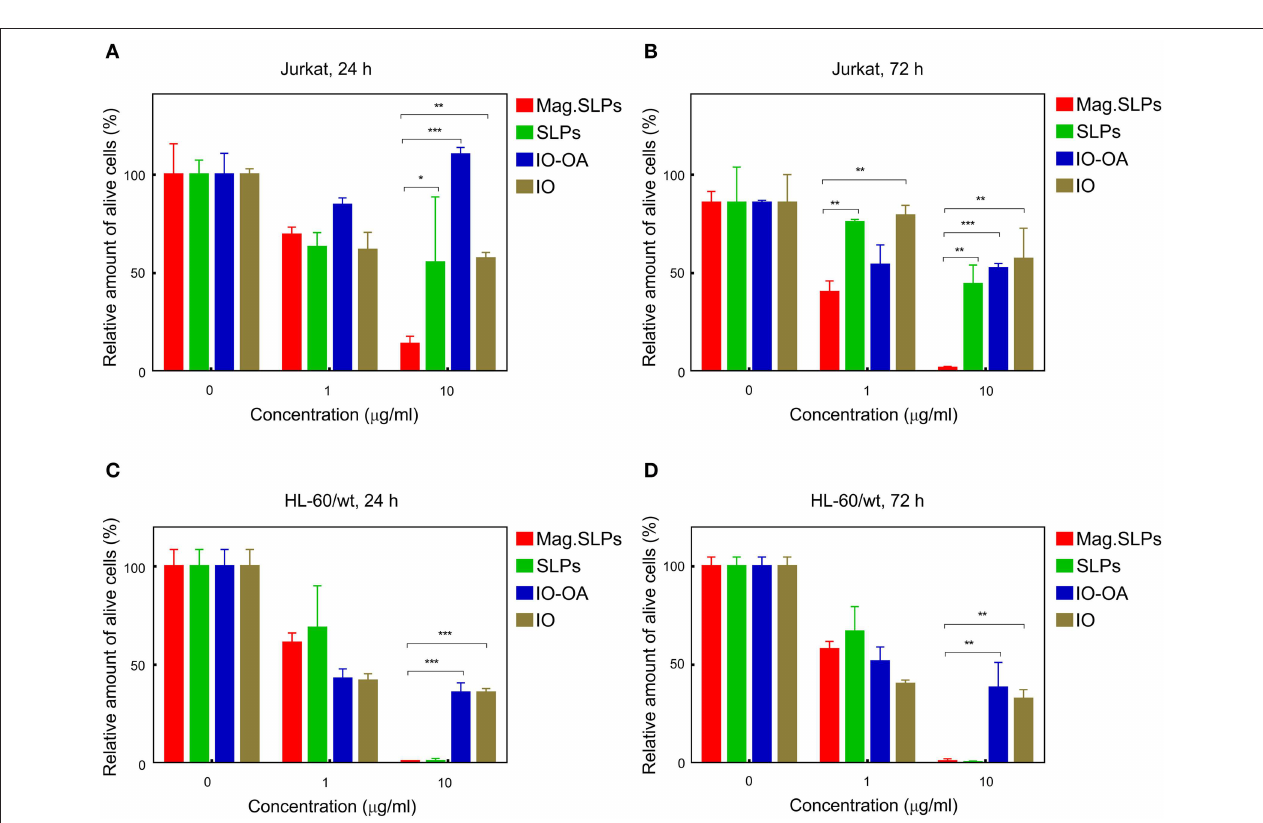
FIGURE 4 | Cytotoxicity of mag.SLPs, SLPs, IO-OA, and IO particles against (A,B) T leukemia Jurkat cells and (C,D) human myeloid leukemia HL-60/wt cells determined by trypan blue exclusion test after (A,C) 24 and (B,D) 72h of incubation. * p ≤ 0.05, ** p ≤ 0.01, and *** p ≤ 0.001 compared to the mag.SLPs.